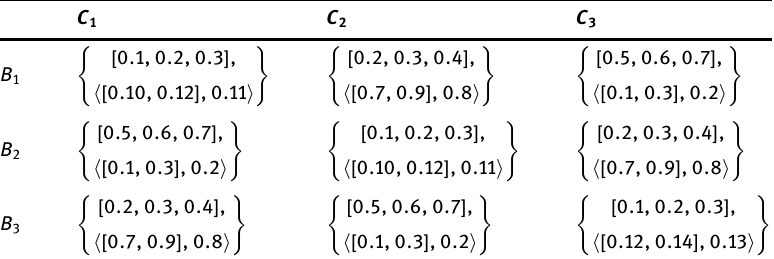
Table 12: Triangular Cubic Fuzzy Decision Matrix.